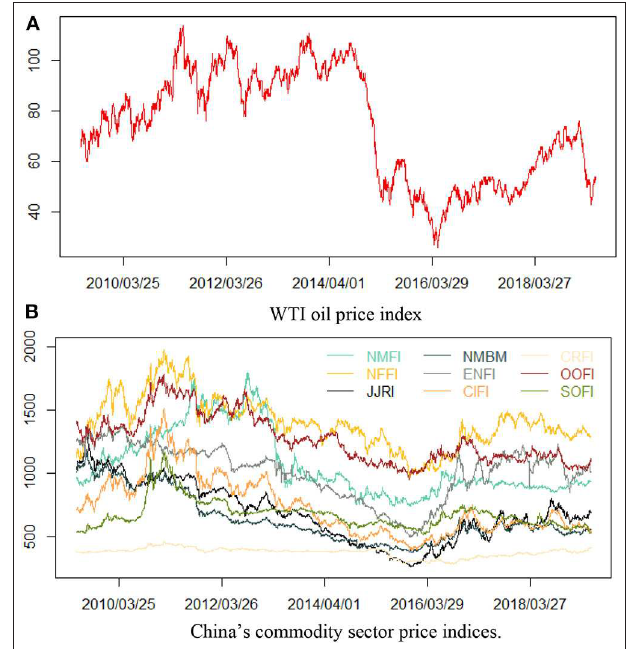
FIGURE 1 | The plot of price indexes. WTI, West Texas